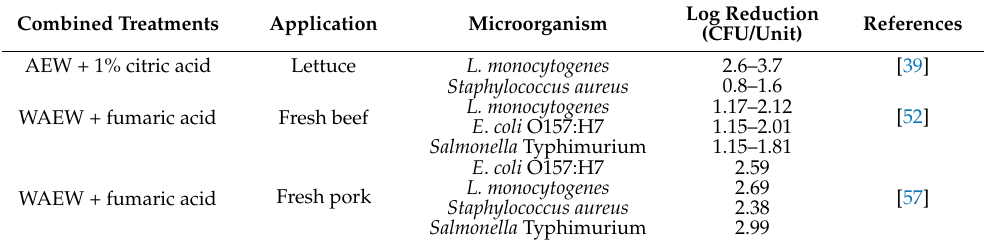
Table 3. Combinations of AEW and WAEW with organic acids.